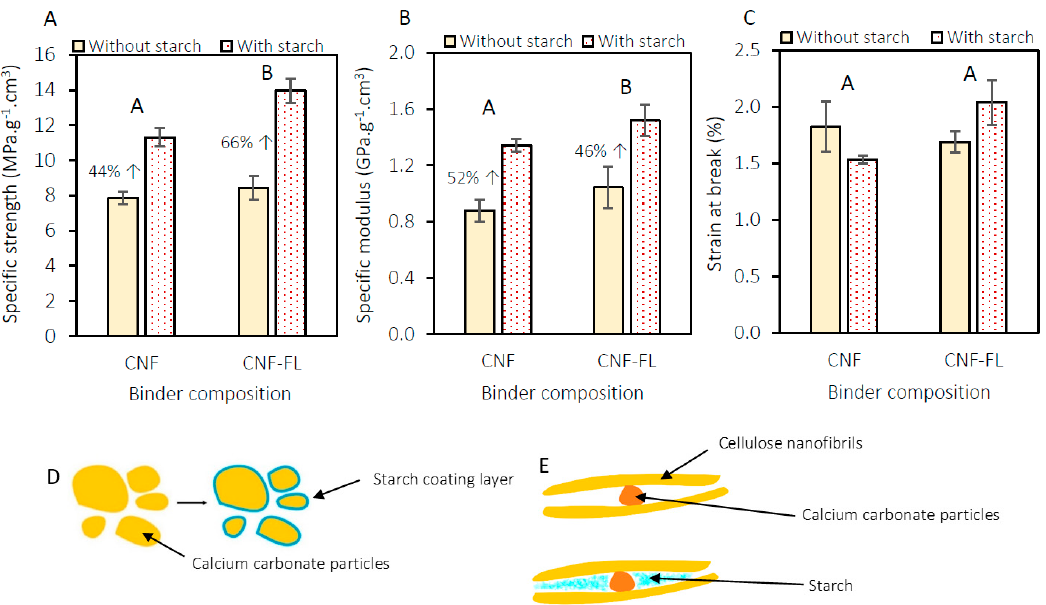
Figure 6. Effect of starch and binder composition (at 10 wt.% load) on ( A ) specific strength, ( B ) specific modulus, and ( C ) strain at break. ( D ) schematic representation of calcium carbonate particles before and after coating with starch, and ( E ) starch filling in the gaps surrounding the calcium carbonate particles.